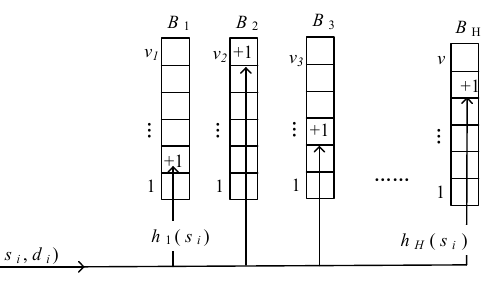
Figure 4. Sketch update procedure.